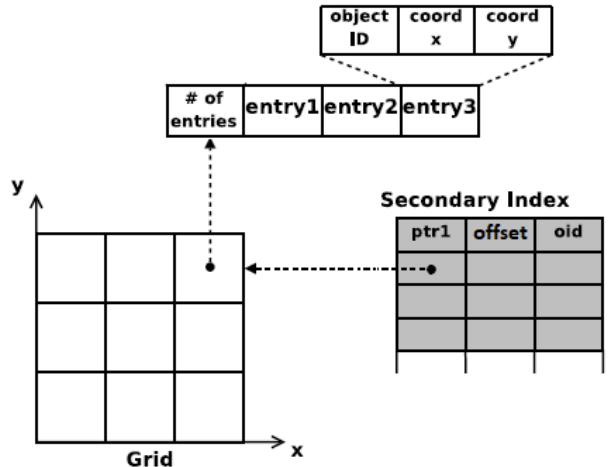
Figure 3. Grid-cells-based index, adapted from